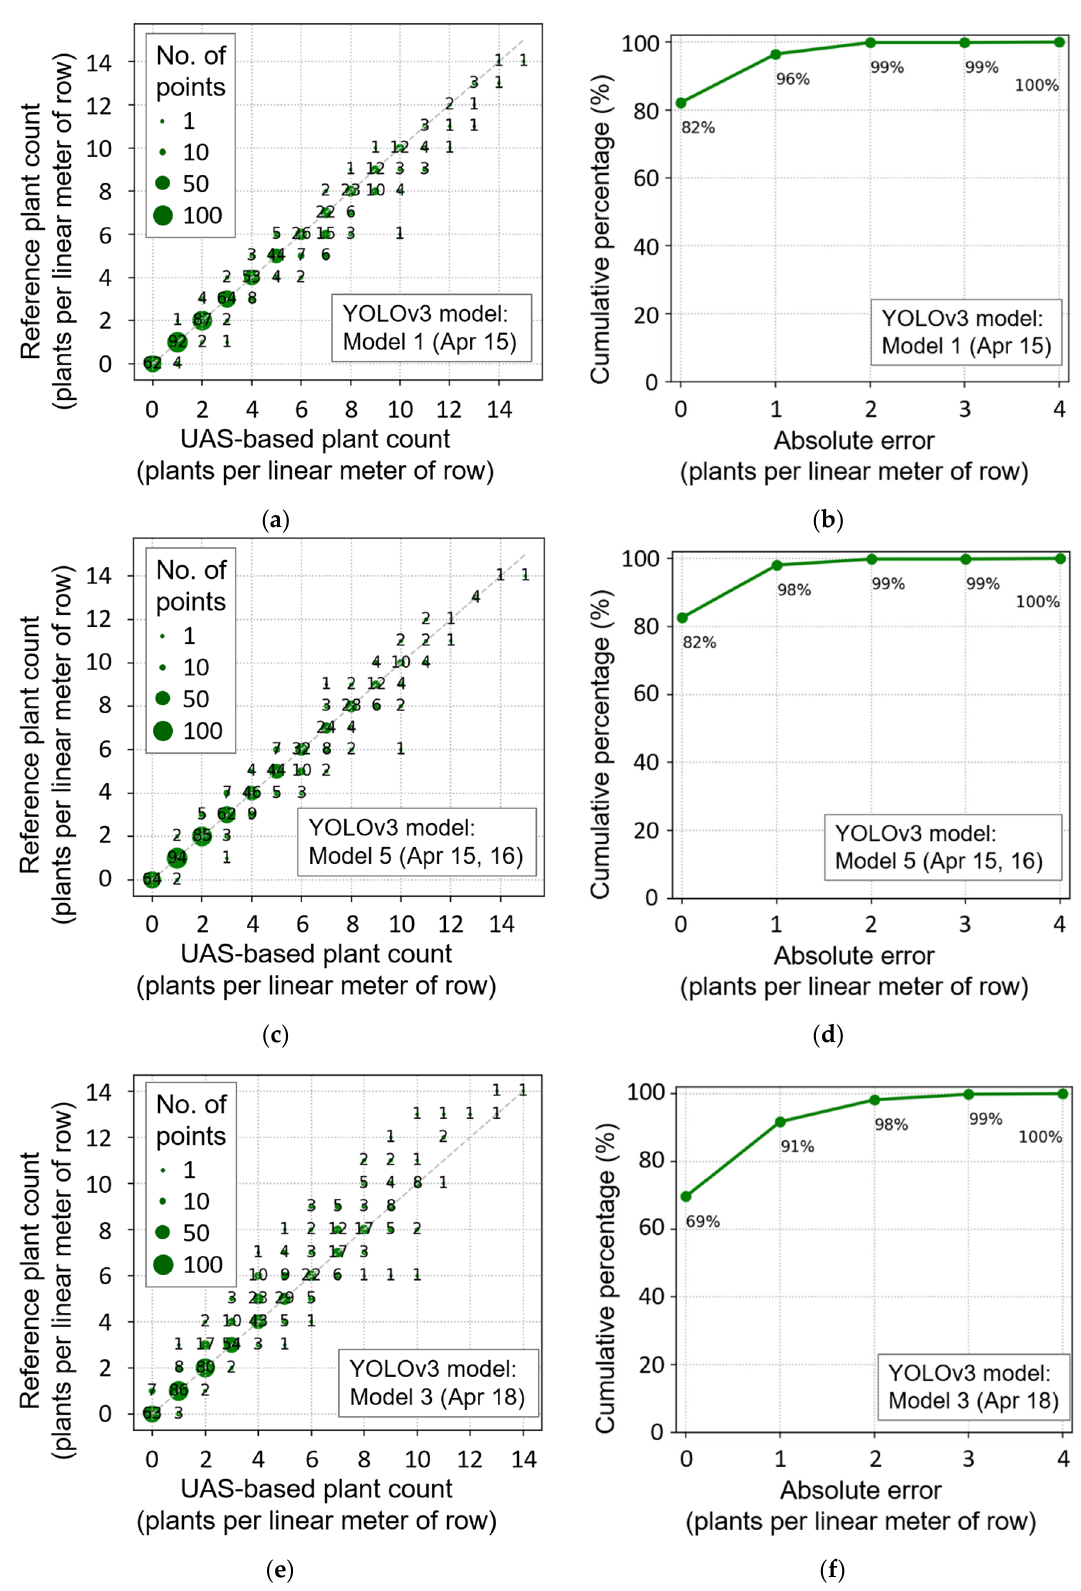
Figure 15. Comparison of a unmanned aircraft systems (UAS)-based plant count with reference plant count measurement ( a , c , e ), and cumulative percentage of plants, according to absolute count error ( b , d , f ) when Model 1 ( a , b ), Model 5 ( c , d ), and Model 3 ( e , f ) were used.